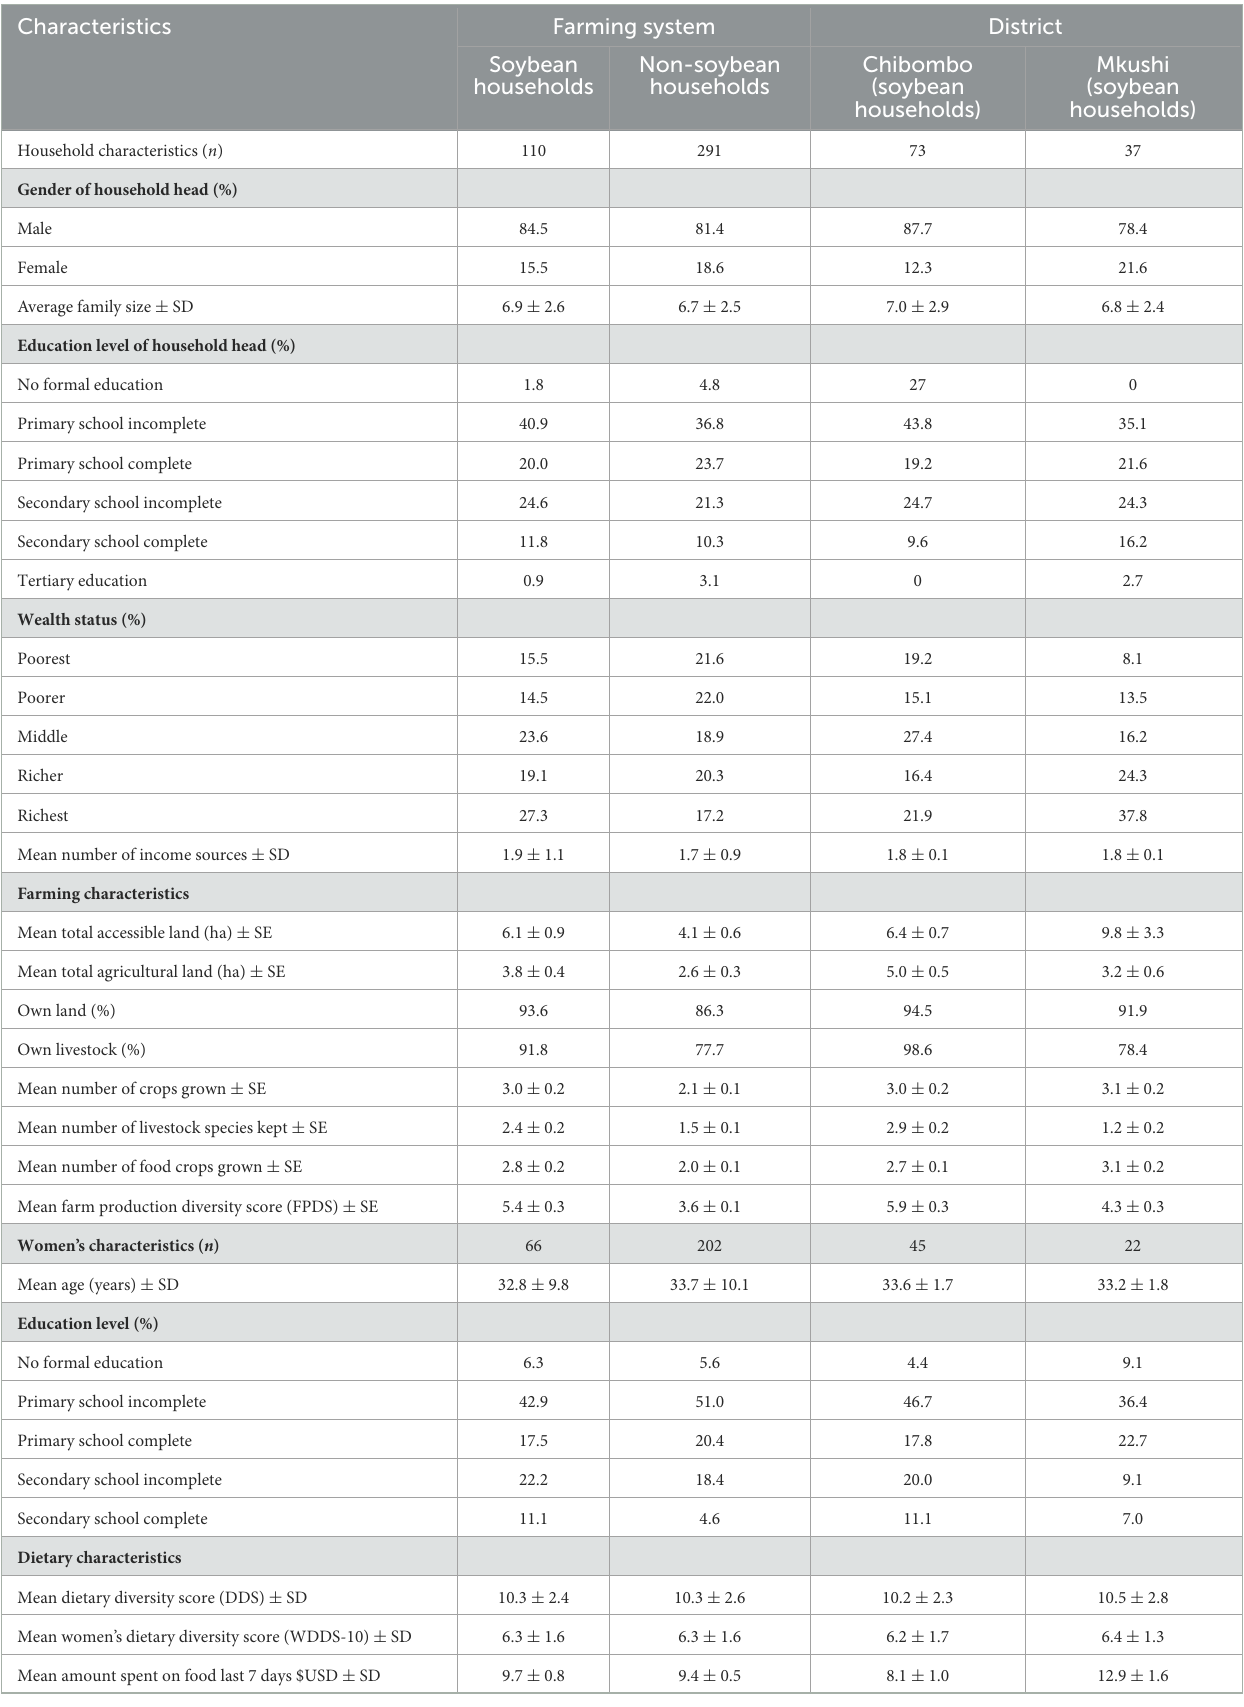
TABLE 2 Demographic, agricultural and dietary characteristics of the sampled households and women according to the farming system and district. Characteristics Farming